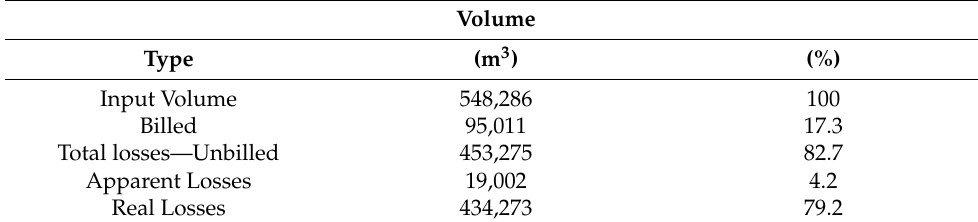
Table 1. Reported reference for Gaula water volumes (in 2019).